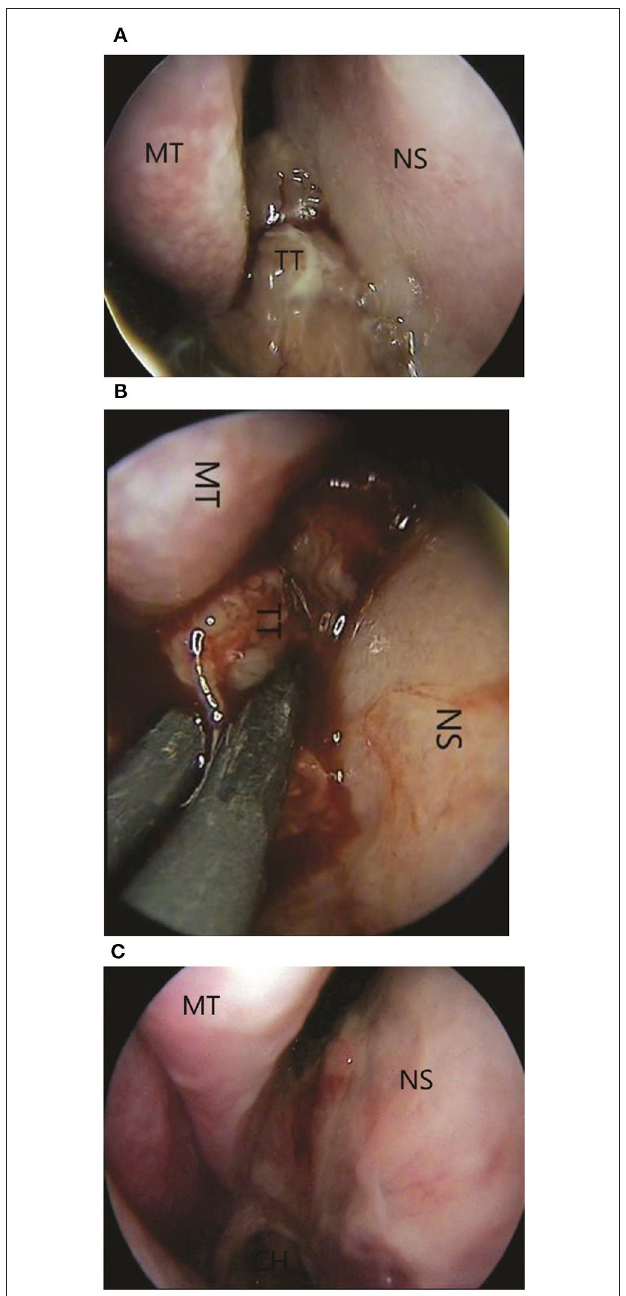
FIGURE 3 | (A) Pre-operative 0-degree endoscopic view of tumour: MT, middle turbinate; NS, nasal septal wall; TT, tumour tissue. (B) The intraoperative view. The using of coagulation: MT, middle turbinate; NS, nasal septal wall; TT, tumour tissue. (C) One-month postoperative 0-degree endoscopic view. No signs of recurrence.